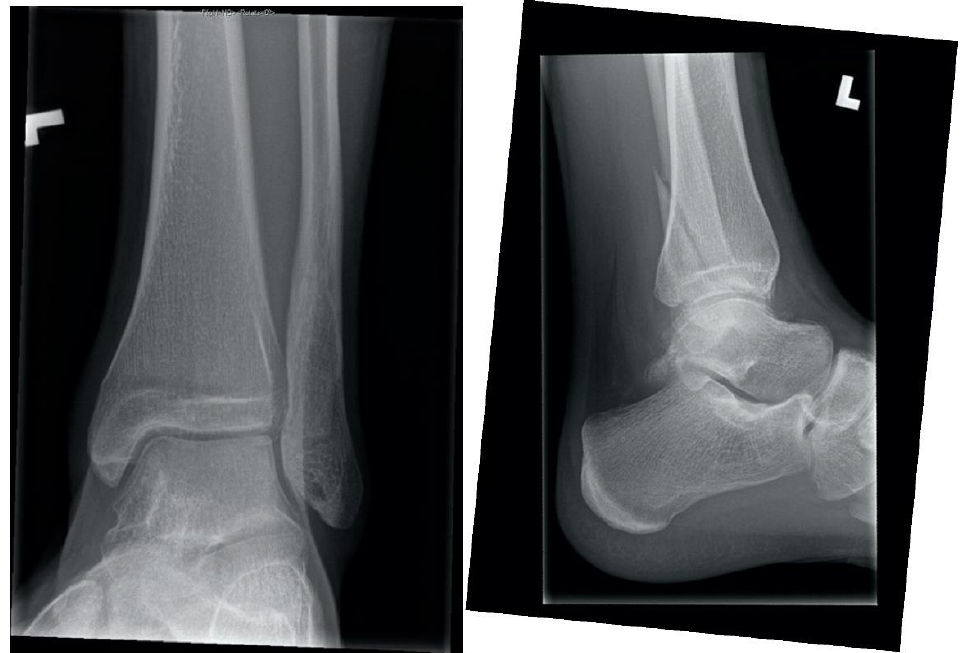
Figure 1. Twelve-week ankle radiographs demonstrating no radiographic union after fibula fracture in a pediatric electronic cigarette user.